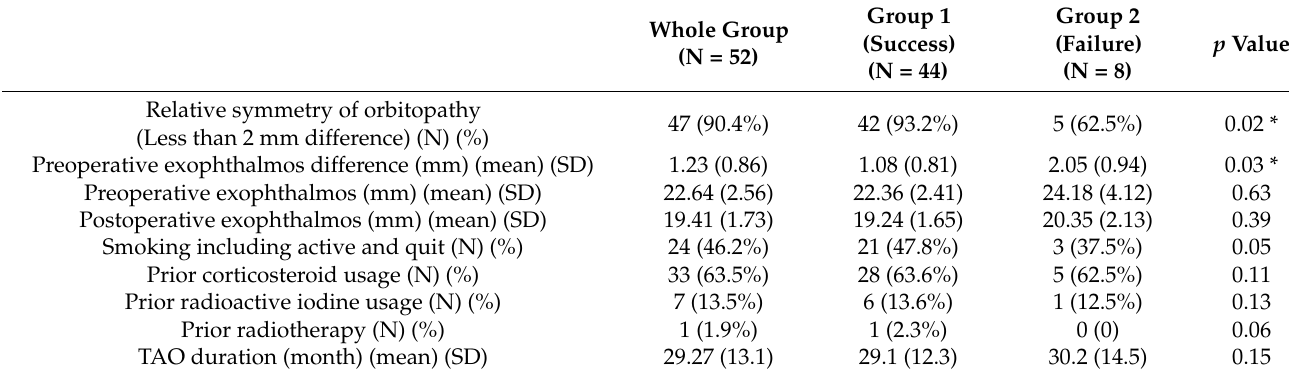
Table 2. Background of patients prior to the surgery.